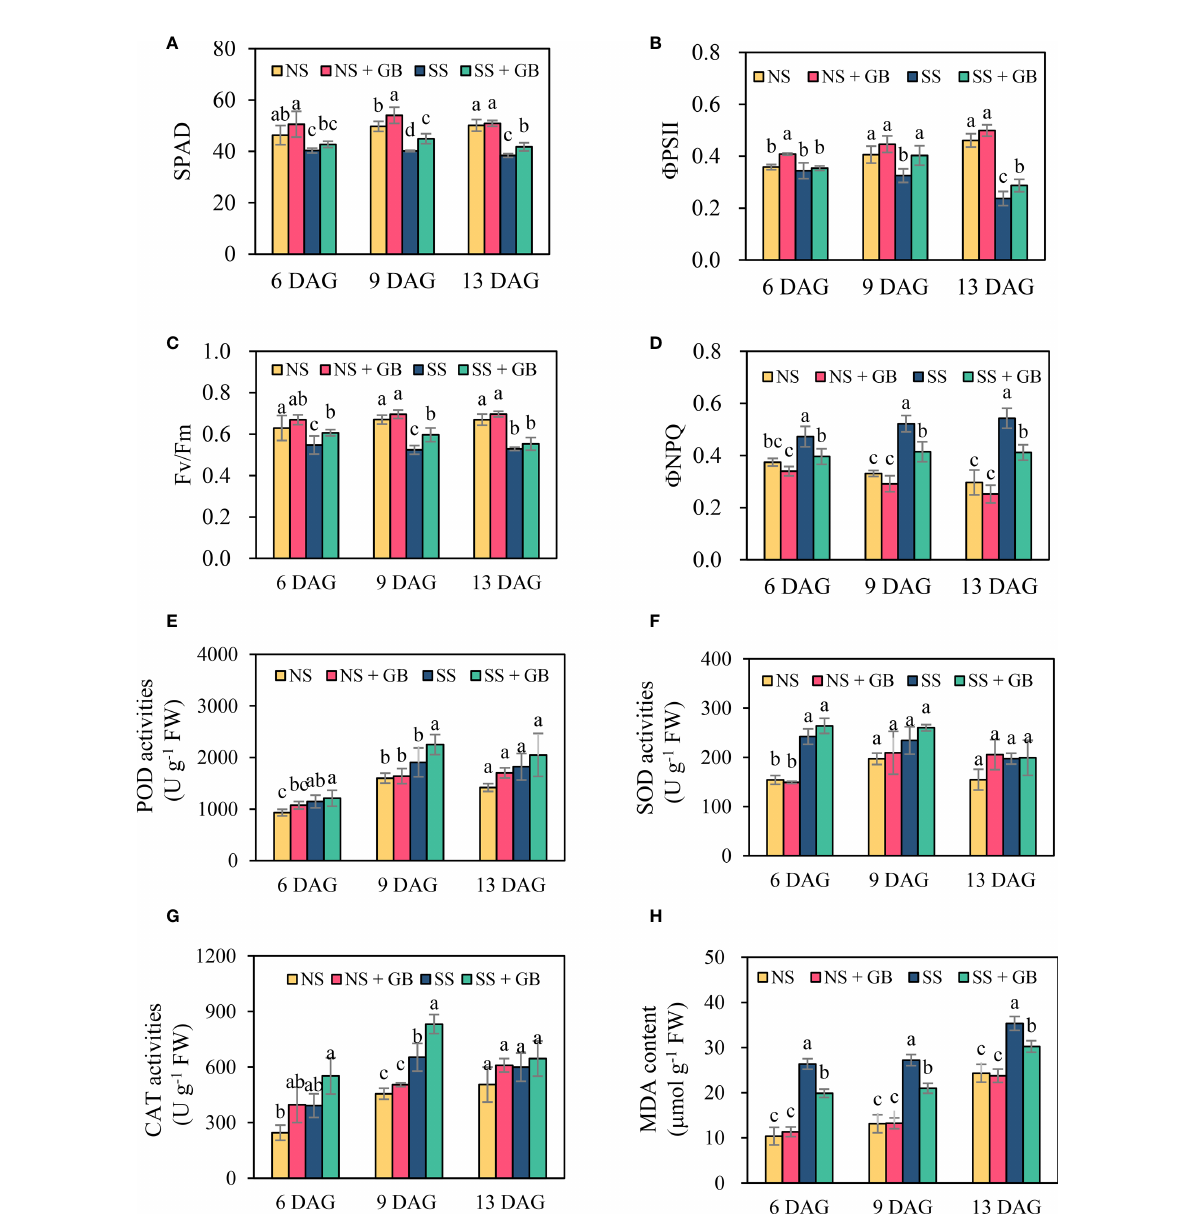
FIGURE 2 Effects of GB on the maize leaf photosynthesis capacities, antioxidases activity and cell membrane stability under non-stressed (NS) and salinity- stressed (SS) conditions. (A) SPAD, (B) quantum ef fi ciency of photosystem II ( F PSII), (C) maximal quantum yield of photosystem II (Fv/Fm), (D) non-photochemical quenching ( F NPQ), (E) peroxidase (POD) activity, (F) superoxide dismutase (SOD) activity, (G) catalase (CAT) activities, and (H) malondialdehyde (MDA) content. The values indicate the mean, while the vertical error bars indicate the standard deviation (n = 5). The different letters in each panel represent signi fi cant differences determined with Fisher ’ s protected LSD test at P <